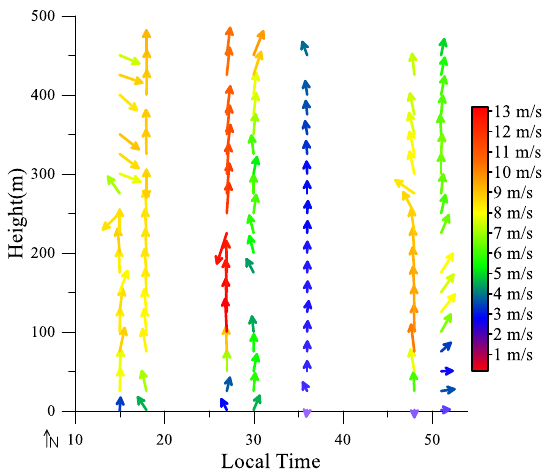
Figure 7. Vertical profiles of the PM 1.0 , PM 2.5 , and PM 10 concentrations ( a : PM 1.0 ; b : PM 2.5 ; c : PM 10 ) and the related meteorological parameters ( d : Air temperature; e : Relative humidity; f : Wind speed) in the boundary layer above Xiaotang during the observation periods (13 November was a floating dust day).